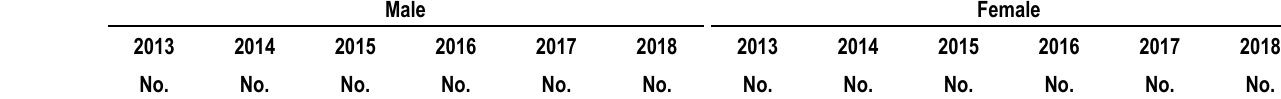
Table 12b. Stage 3 (AIDS) attributed to heterosexual contact, by selected characteristics, 2013–2018—United States and 6 dependent areas (cont) Male